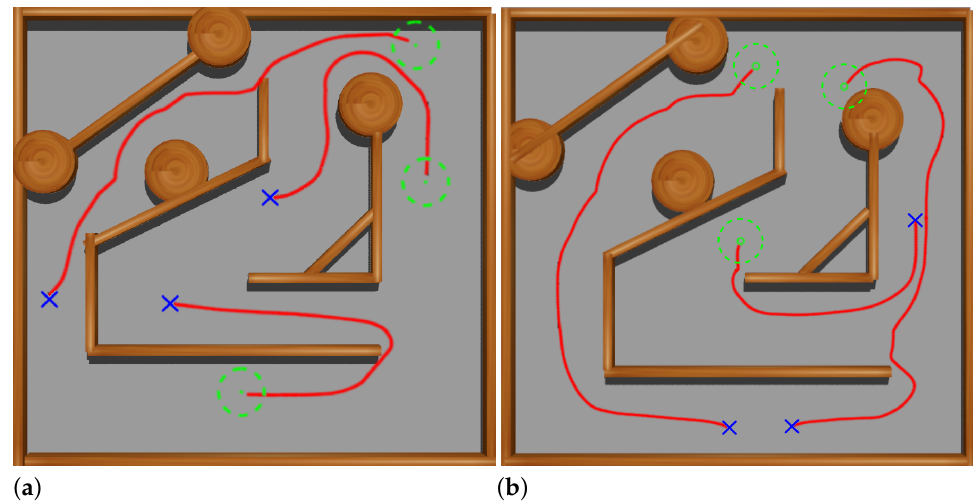
Figure 14. Validation tests at the end of the first ( a ) and second ( b ) stages. The followed paths are represented with red lines.